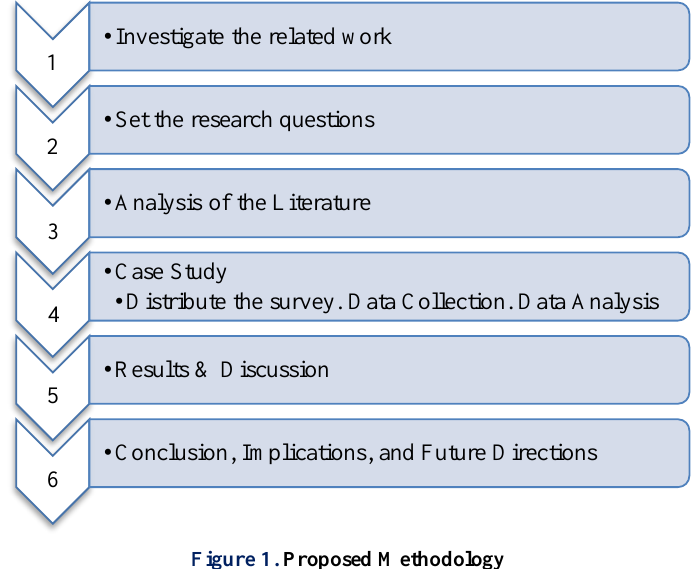
Figure 1. Proposed